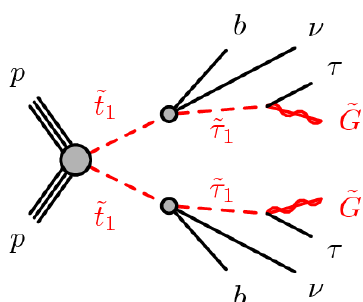
Figure 4: The simplified model for production and decay of SUSY particles considered [ 11 ]